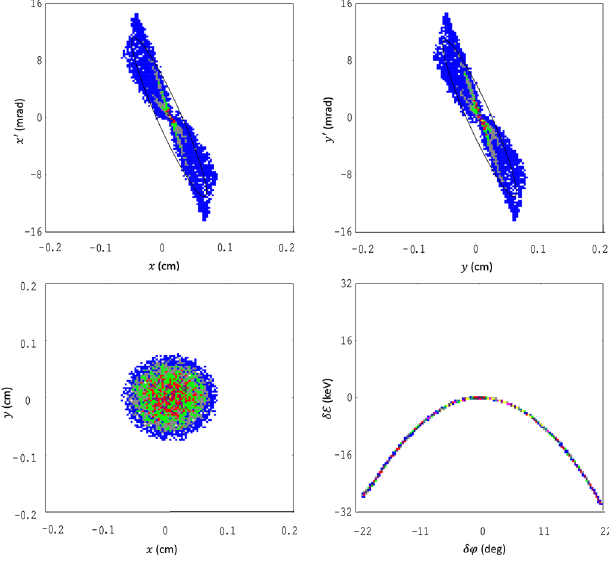
FIG. 25. The bunch phase-space at the output of the rf gun cavity. The cathode is concave.